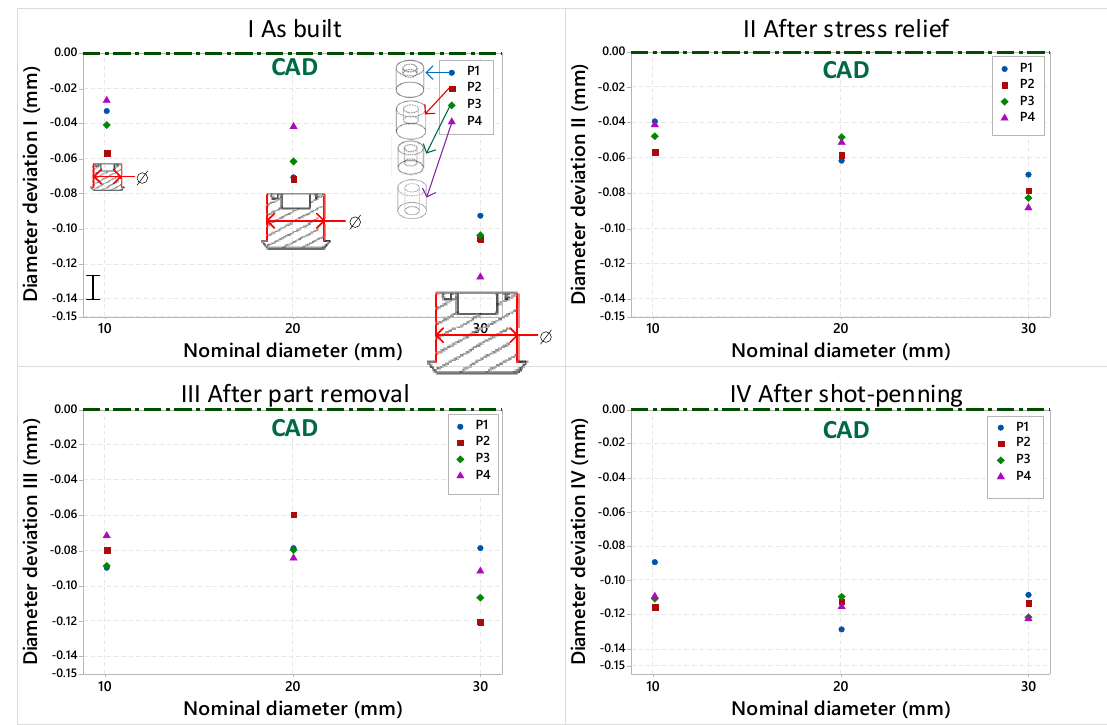
Figure 12. External diameter deviations of 12 Shape A artifacts at each post-processing step (as-built I, after stress relief II, after part removal III and after micro shot peening IV); P1–P4 pocket depth.